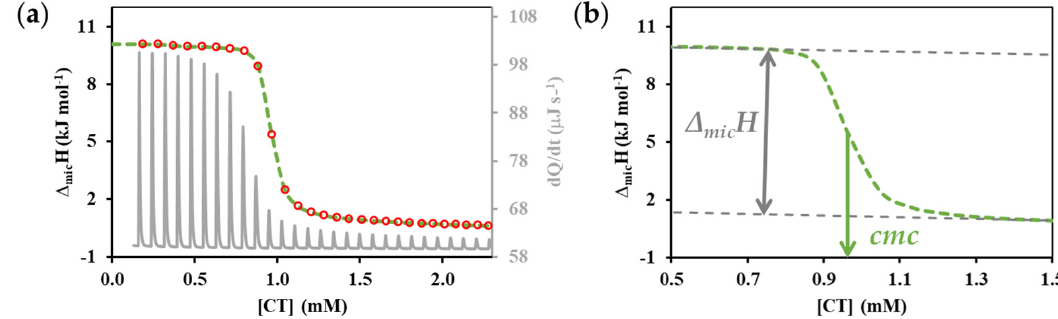
Figure 2. ( a ) Measured ITC raw data (grey continuous curve) and enthalpogram (red circles) for the titration of ionic surfactant (CT) at 298 K where the dashed green curve indicates the calculated enthalpogram; ( b ) The sigmoidal Boltzmann equation-based model curve of the measured enthalpogram with a schematic illustration of the parameters ( ∆ mic H and cmc ) that can be calculated from the nonlinear parameter estimation.